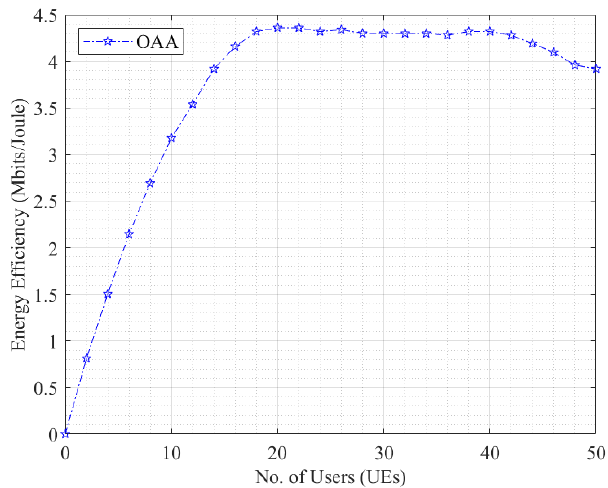
Figure 6. The number of users vs. corresponding average throughput.